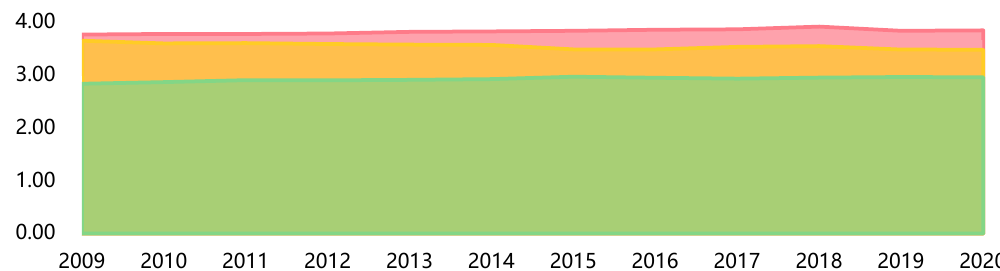
Figure 3. Population changes in the study area (2009–2020).